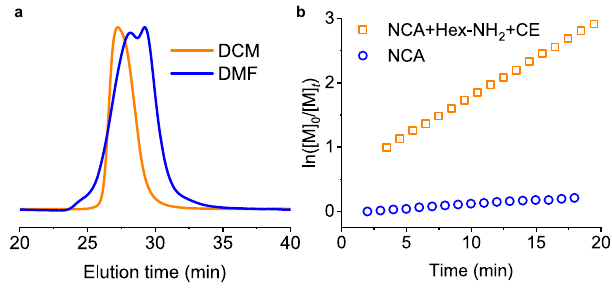
Fig. 4 Minimal side reactions with CE-catalyzed polymerization of NCA. a Normalized GPC-LS traces of the obtained PBLG in DCM and DMF initiated by α -helical PBLG macroinitiator in the presence of 18-C-6. [M] 0 / [I] 0 = 1000, [M] 0 = 100 and 400mM for the polymerization in DCM and DMF, respectively. b Semilogarithmic kinetic plot of polymerization of BLG- NCA in a biphasic system in the presence and absence of Hex-NH 2 and CE.